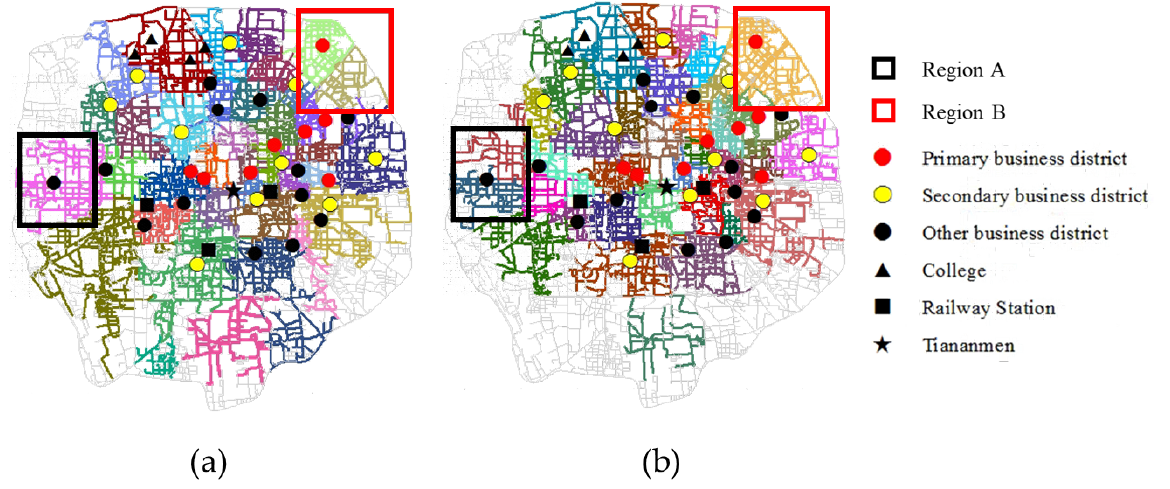
Figure 14. The overlapping results of spatial communities during afternoon rush hours and high- lighted places: ( a ) spatial communities discovered on Monday; ( b ) spatial communities discovered on